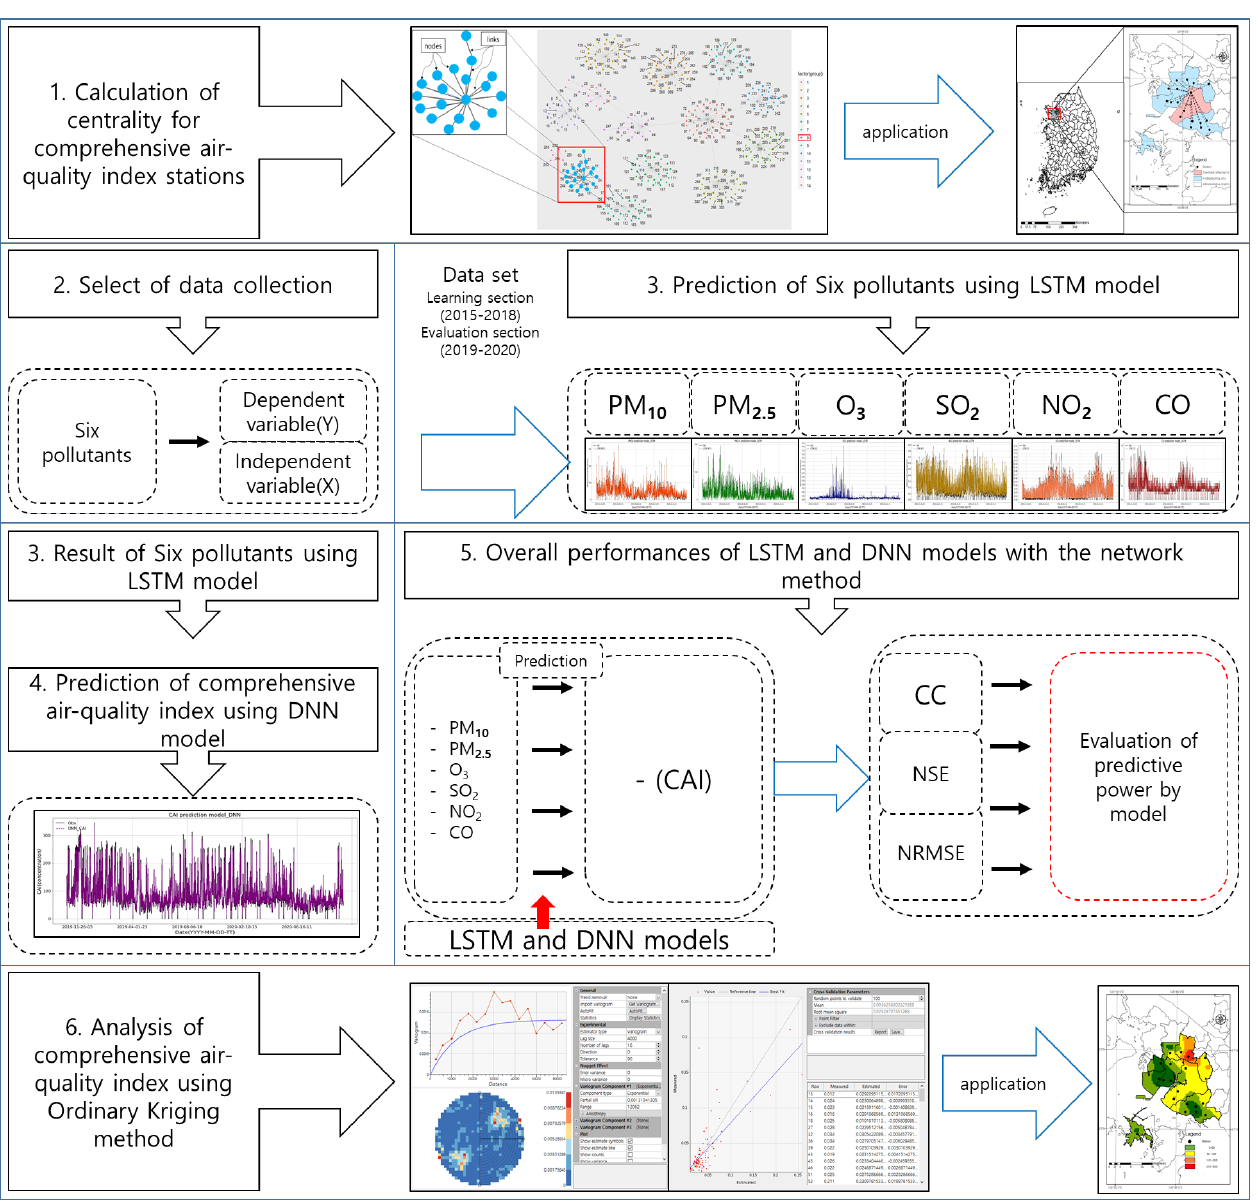
Figure 2. Application of deep learning models and network methods for CAI prediction.